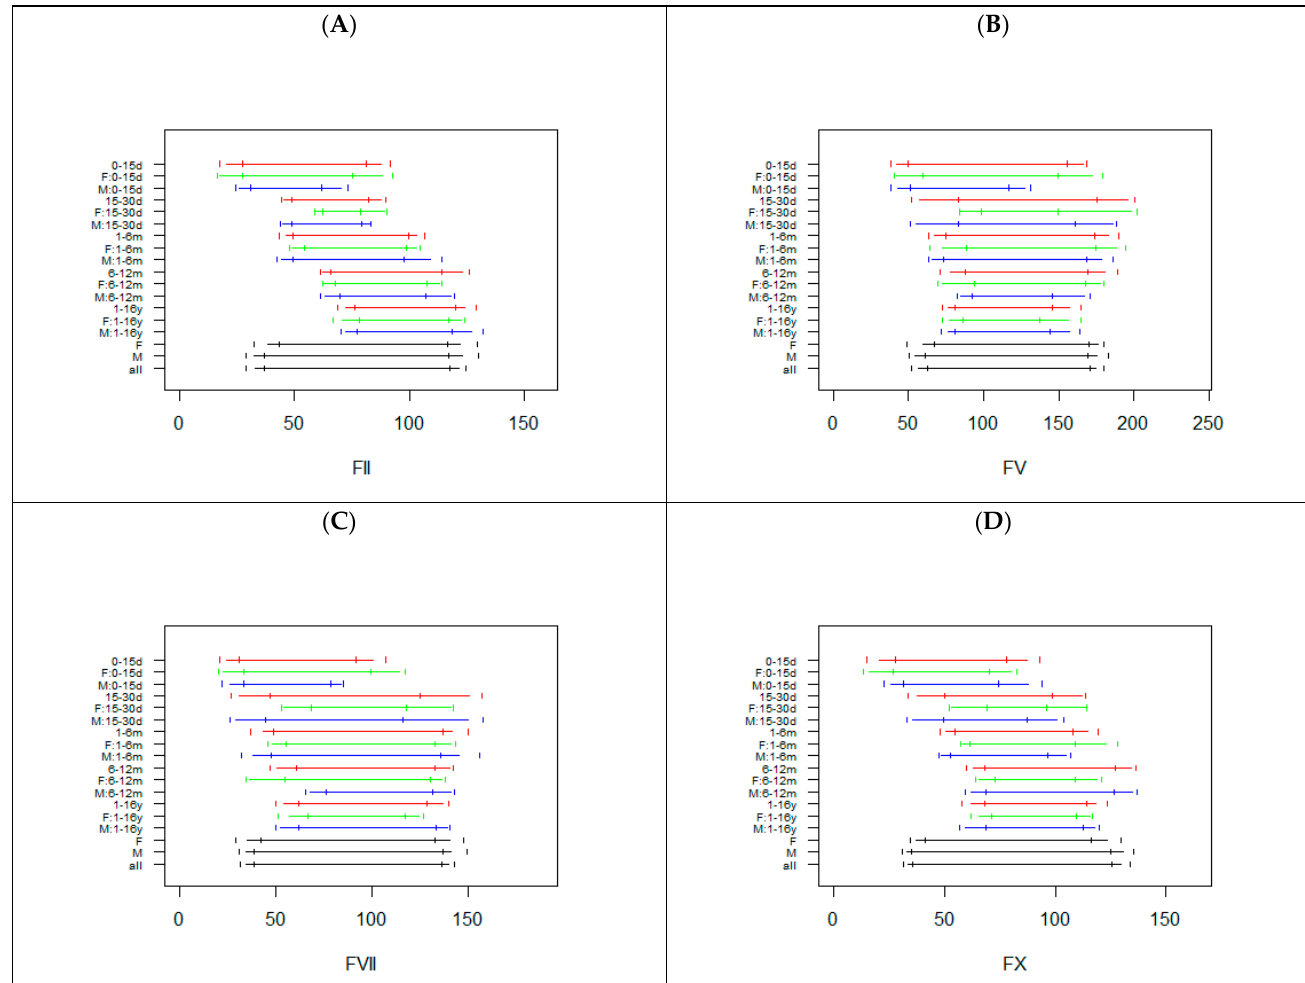
Figure 2. Reference intervals for FII ( A ), FV ( B ), FVII ( C ), and FX ( D ) in the subjects subgrouped by sex and age. The horizontal segments represent the RIs, while the vertical segments indicate the limits of the 90% confidence interval of the RIs. For each class RIs are reported combining males and females (red) or, respectively, only in females (green) or males (blue). The last three RIs are calculated without taking into account age, in females, males, or in the whole sample. d = days, m = months, y = years, F = females, M = males.